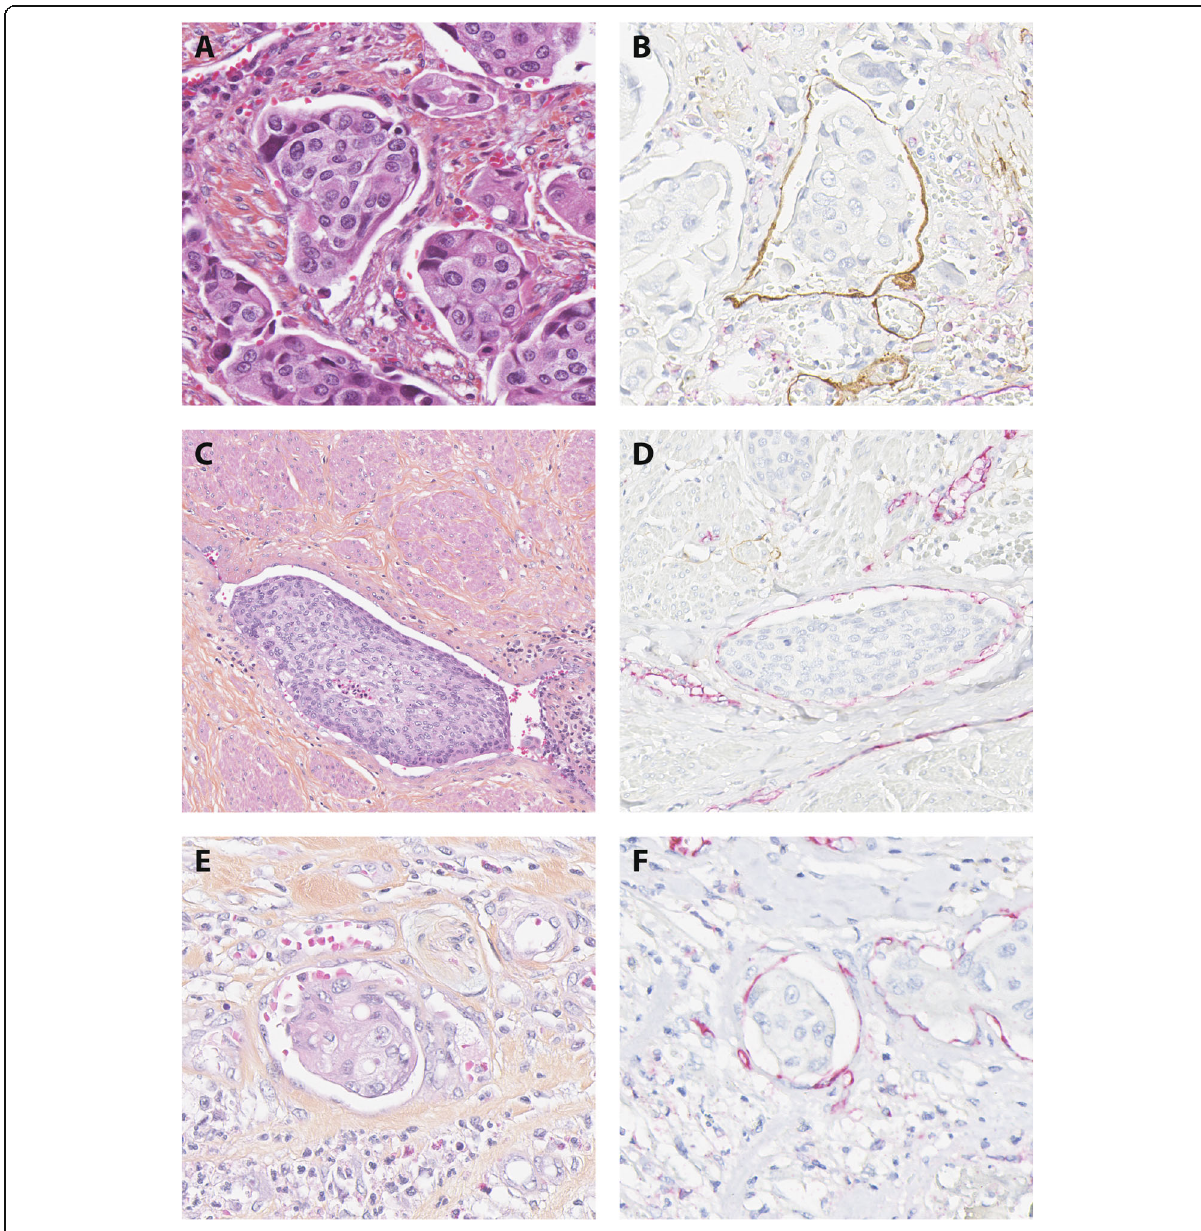
Fig. 1 Histological images of LVI and BVI by immunohistochemistry (× 400). Footnotes: A , VI, HAS section. B , the same vessel, positive for D2 – 40 (LVI). C , VI, HAS section. D , the same vessel, positive for CD31 (BVI). E , VI, HAS section. F , the same vessel, positive for CD31